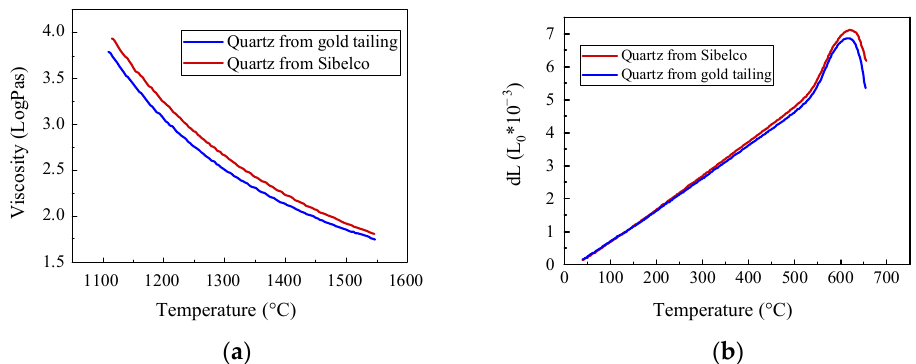
Figure 10. Quality comparison of quartz from Sibelco and from gold tailings. ( a ) Temperature–viscosity